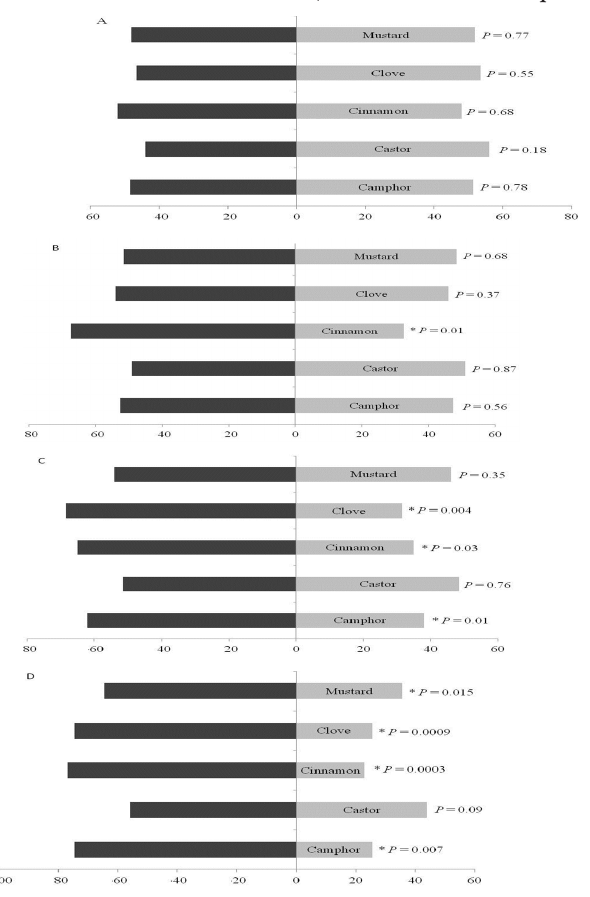
Fig. 2. Preference (%) of Bruchidius incarnatus for a half filter paper treated or not with five essential oils with concentrations (A) 0.5 % (B) 1 %, 2 % and (c) 4 % after 4 h, in free choice test. * Significant values at 5 % probability by t-paired test ( p < 0.05)